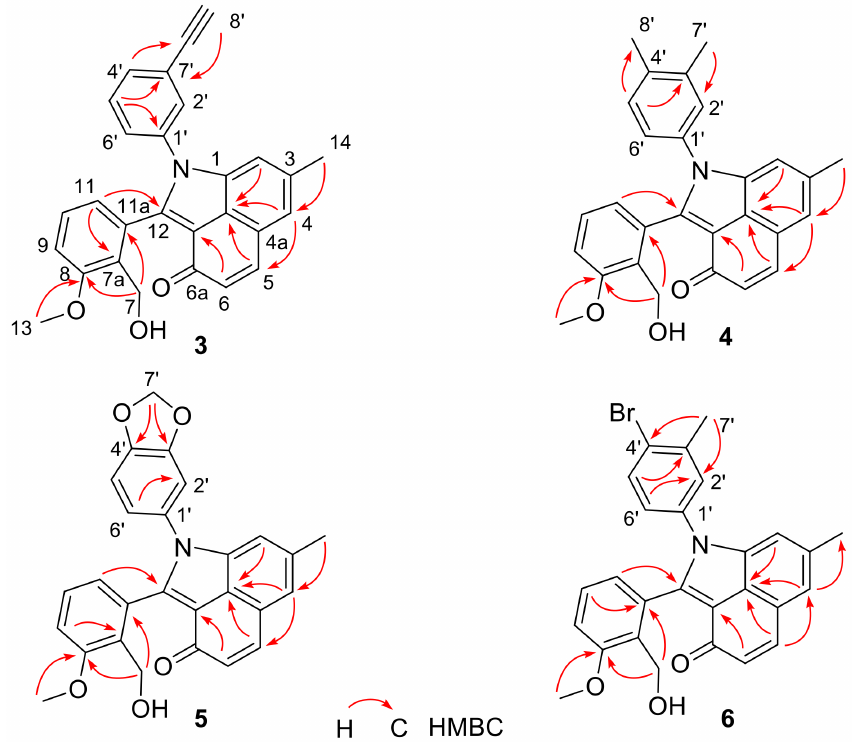
Figure 2. Key HMBC correlations of compounds 3 – 6